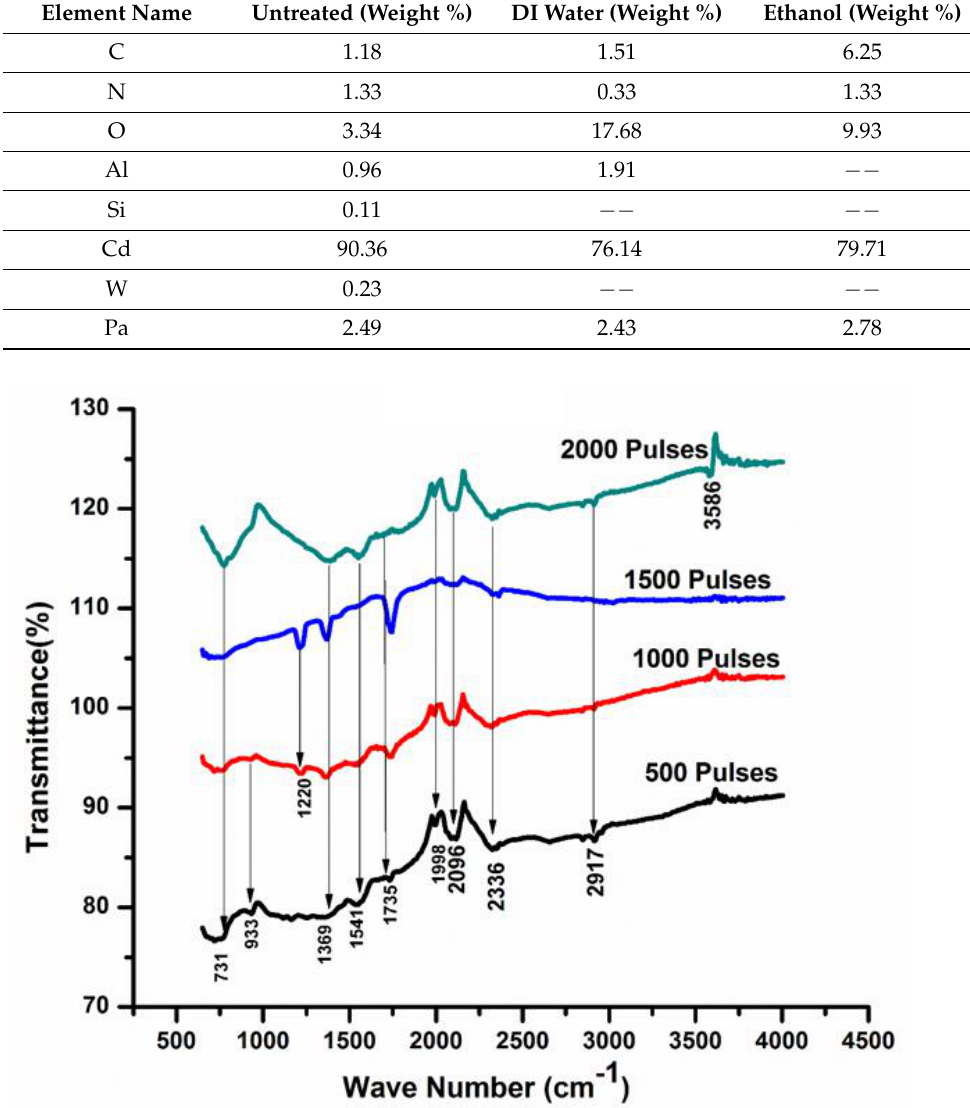
Figure 8. FTIR analysis of laser ablated Cd exposed to 500, 1000, 1500, and 2000 laser pulses for a constant fluence of 3.6 Jcm − 2 in ethanol.